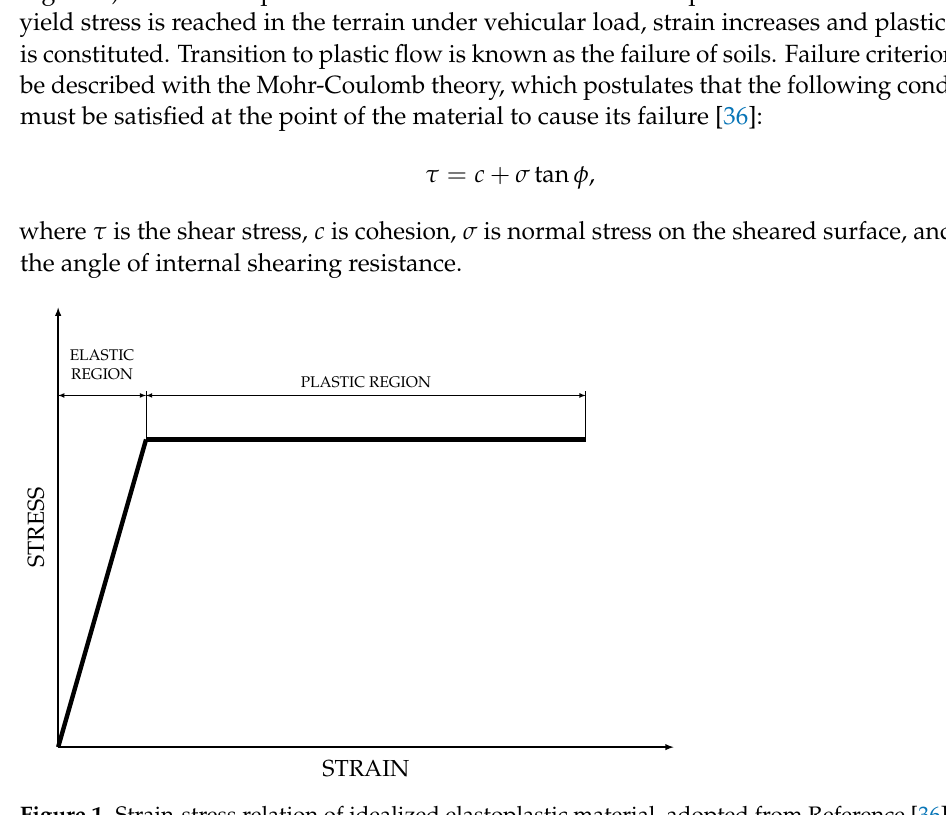
Figure 1. Strain-stress relation of idealized elastoplastic material, adopted from Reference [36]. Cohesive forces bind soil grains together irrespective of normal pressure between the particles, e.g., for saturated clay only cohesion c is presented. However, when grains are not held together by cohesion, they can move upon each other and, while pressed